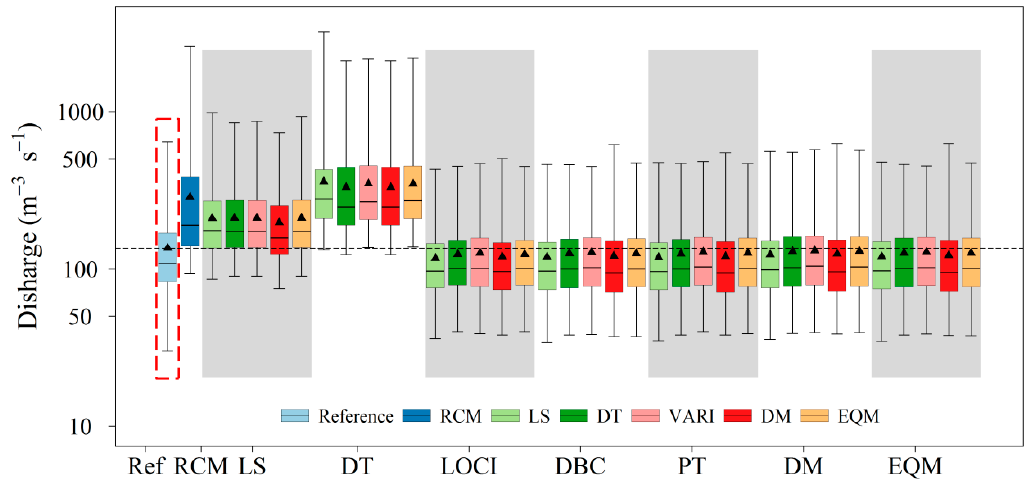
Figure 13. Box plot of daily discharge intensity quantiles at the DSK station for those simulated using observed data, RCM data, and bias-corrected data grouped by precipitation corrected methods.